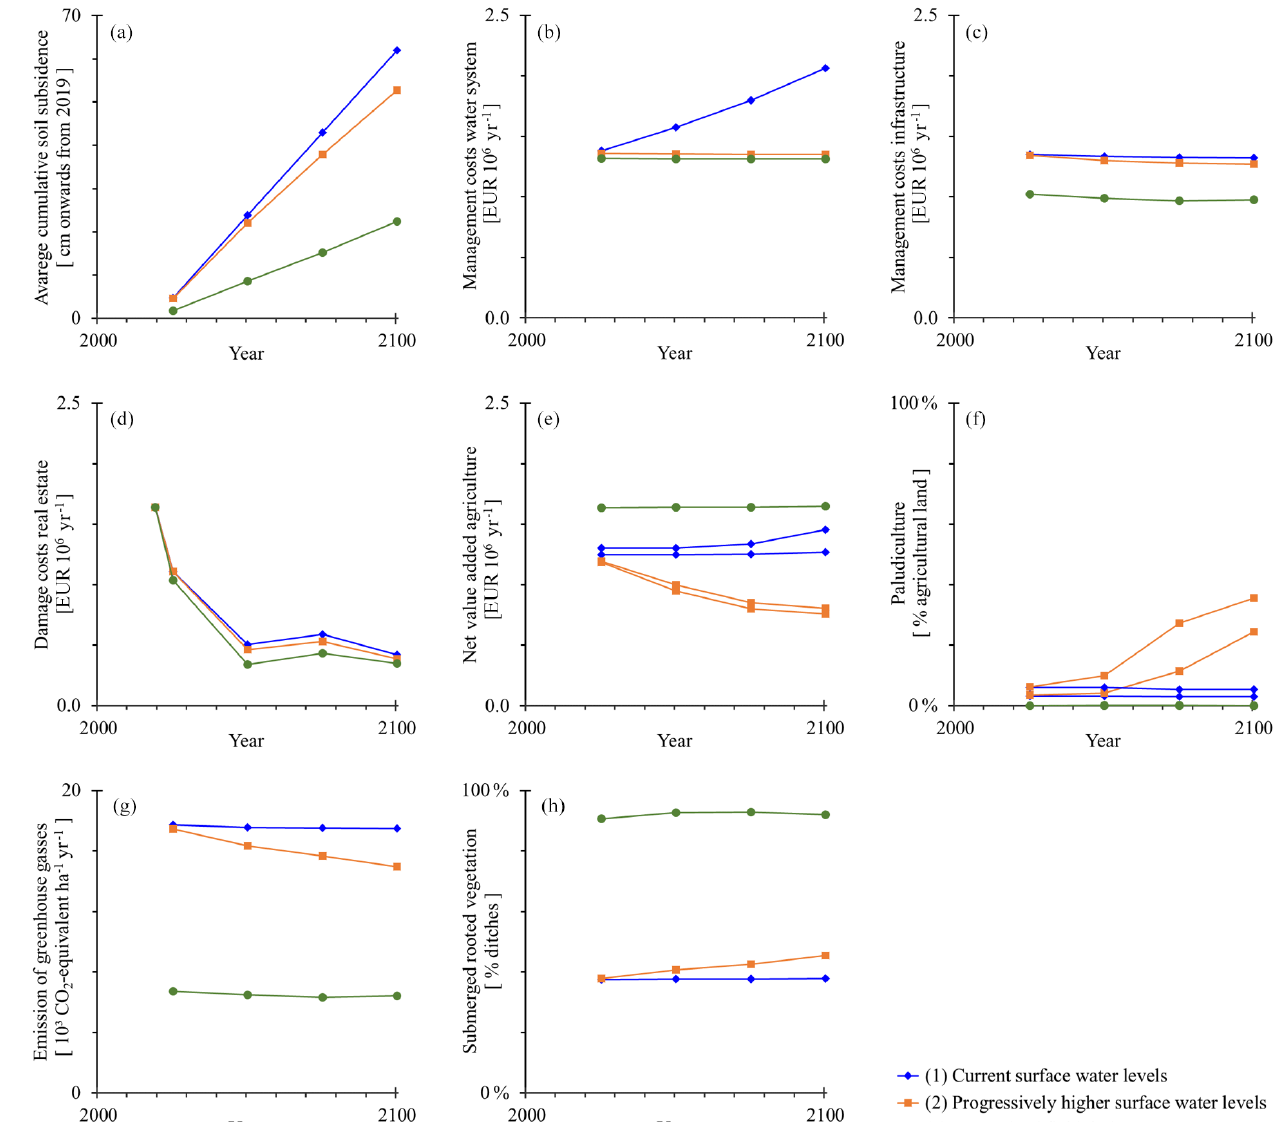
Figure 2. Effects of the three management strategies. The upper and lower limits to the range of agricultural values (e, f) reflect the uncer- tainty regarding paludiculture. The uncertainty regarding dairy products is not reflected in the results (e, f)